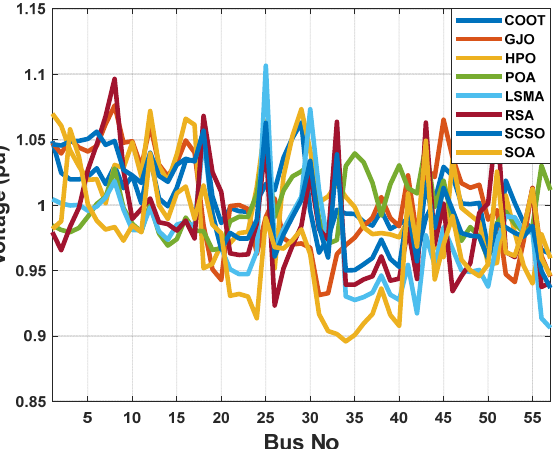
Figure 21. Boxplot of POA and other compared algorithms for case 1 in a standard IEEE 57-bus test system. Case 2: Power Losses Minimization Real power loss was the desired outcome here. Table 8 shows the results of the POA algorithm used to determine the most appropriate solution. In order to minimize system losses, the POA algorithm is extremely useful for setting the precise parameters of the control variable. Therefore, when the POA algorithm is applied, real power losses are drastically reduced to 17.34087 MW. According to Figure 22, real power losses utilizing the POA method are steeply convergent. Within 20 iterations, the algorithm fully con- verges to the optimum solution, showing the rapid convergence of the POA algorithm. The evaluated real power loss is compared to that found before using published popula- tion-based optimization techniques in order to assess the performance of the approach. Table 8 shows how the POA algorithm outperforms these prior methods. Figure 23 illus- trates how most of the solutions found using heuristic optimization techniques are im- practical. This is mostly due to voltage magnitude infringements at one or more of the system load buses.